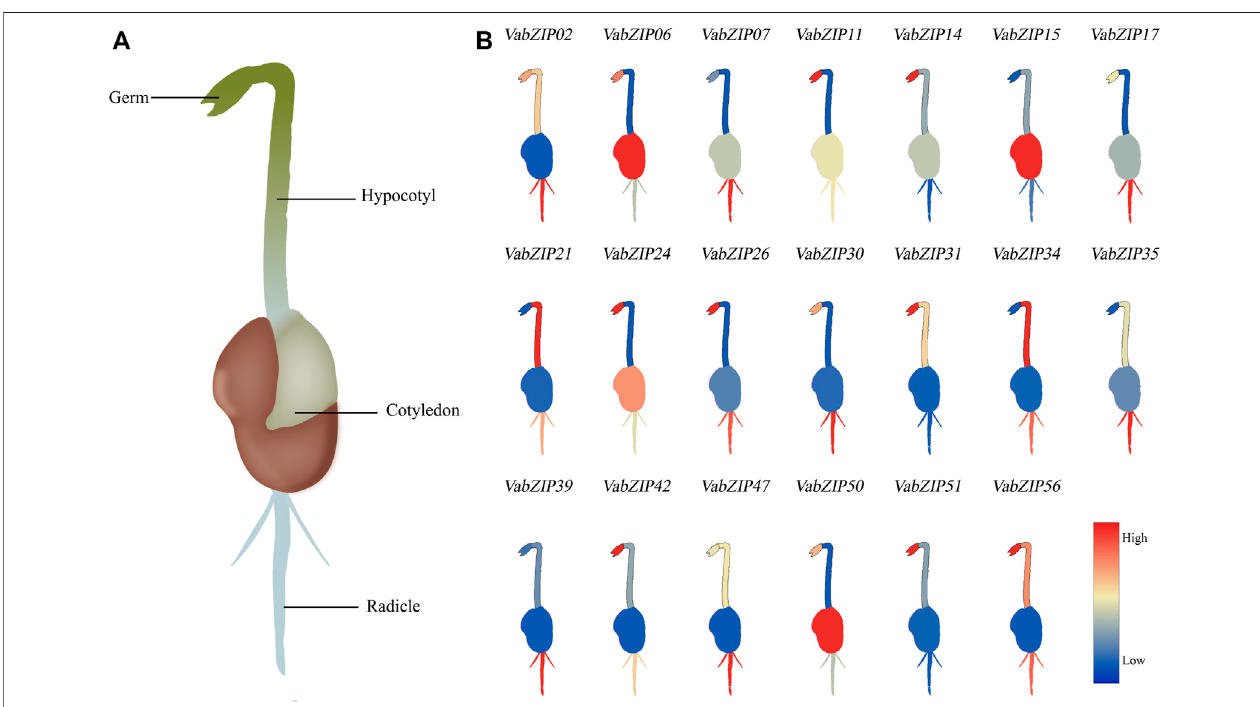
FIGURE8| Tissue-speci fi cexpressionanalysisof VabZIPs atthebudstage. (A) Schematicillustrationoftissuesatthebudstageofadzukibean. (B) Expressionsof VabZIPs in different tissues. The change in color from red to blue indicates a high to low expression.